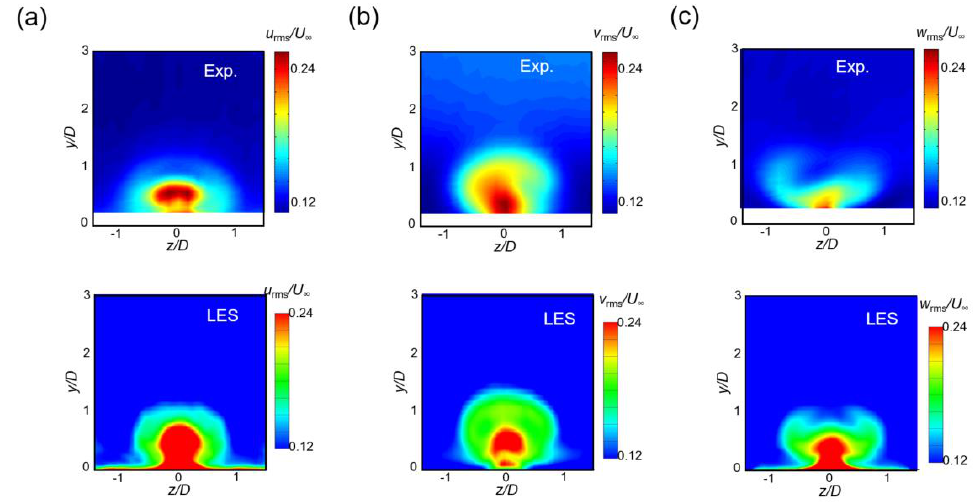
Figure 13. Turbulence intensities of a film-cooling jet at x / D = 2.5 [5]: ( a ) u rms , ( b ) v rms , and ( c ) w rms.